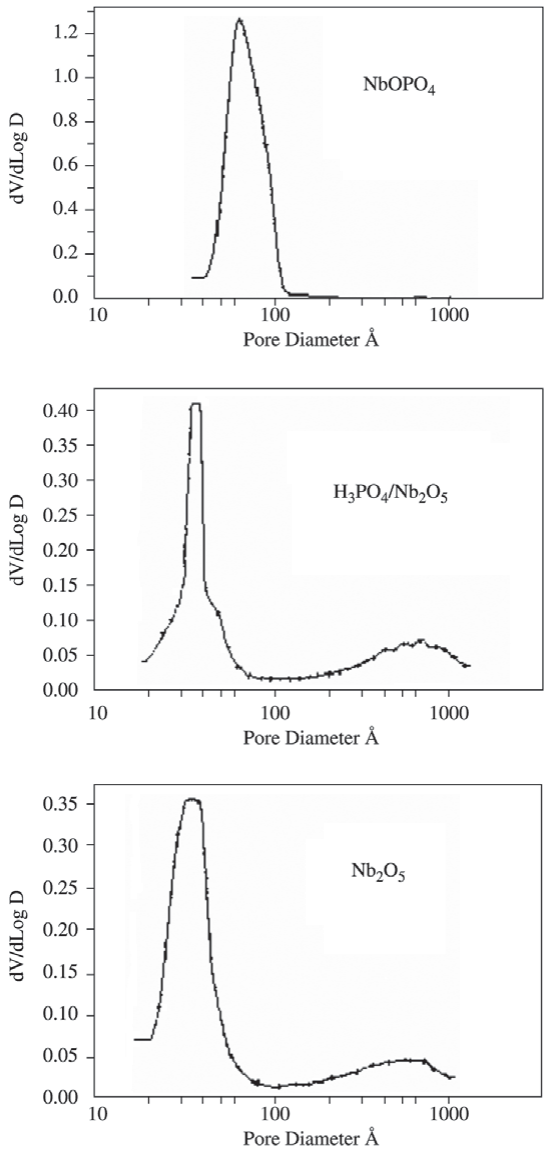
Figure 3. Pore size distribution of the different catalysts.